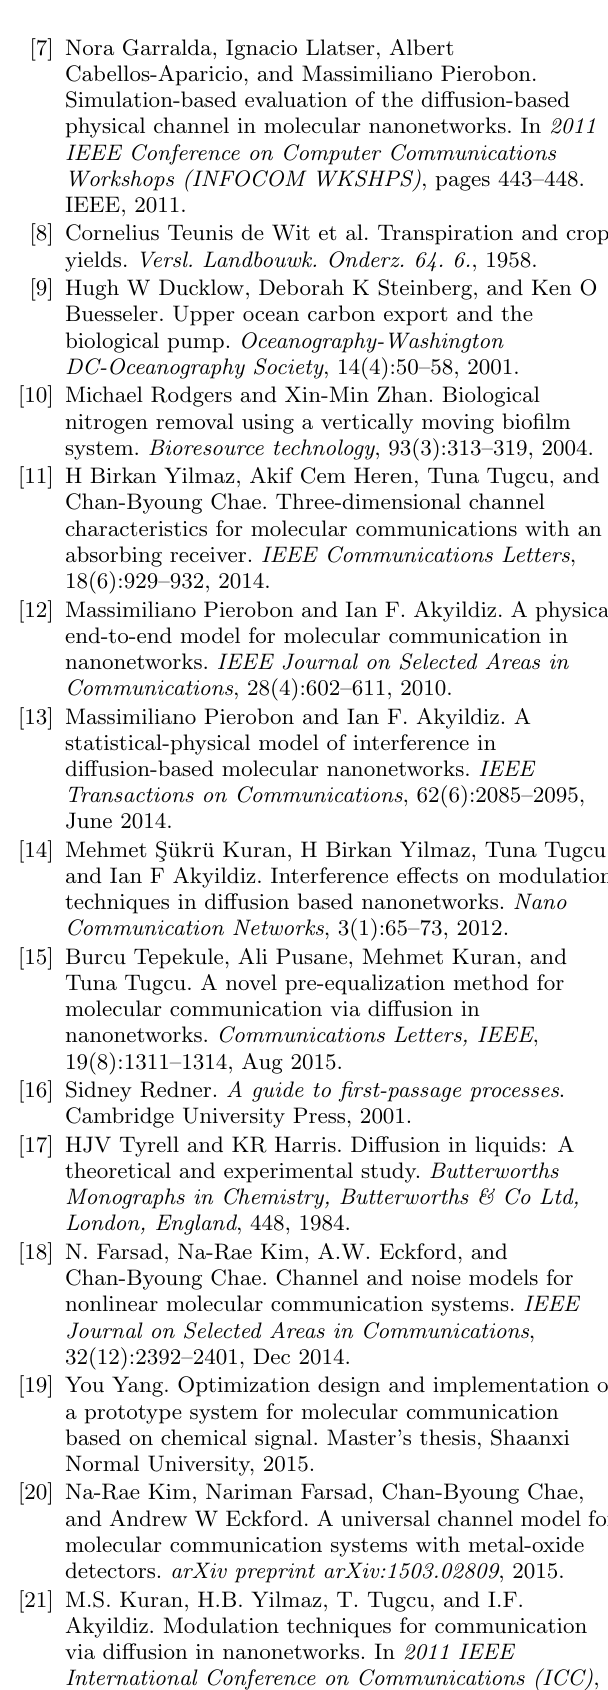
Table-top molecular communication: Text messages through chemical signals. CoRR , abs/1310.0070,